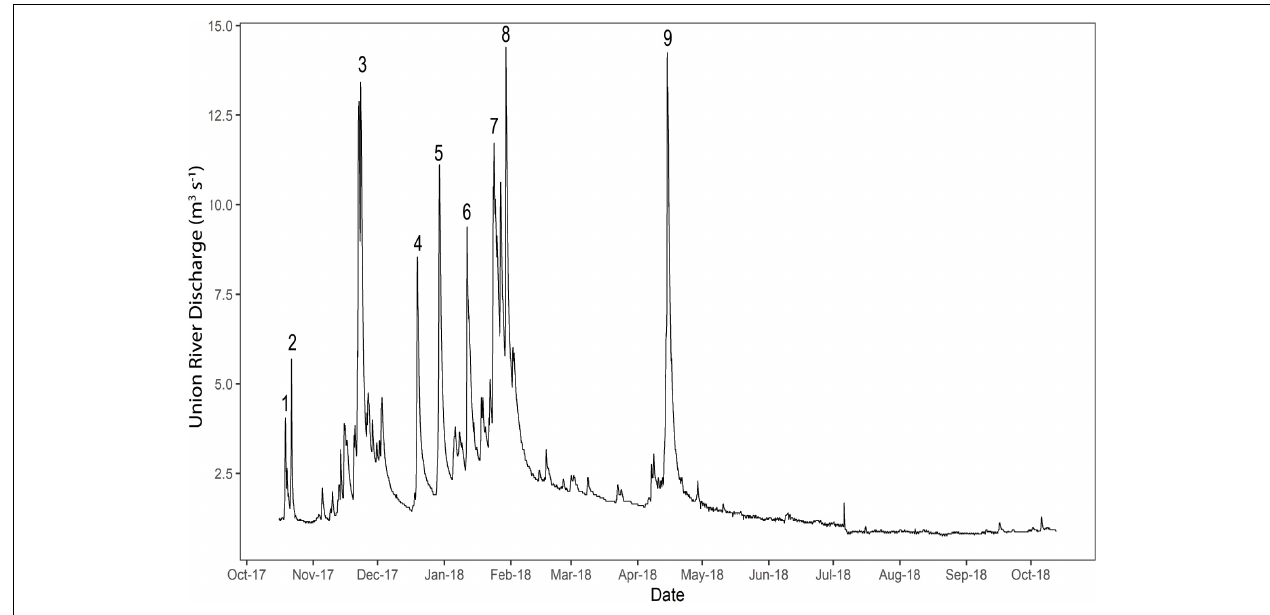
FIGURE 2 | Time series of discharge corrected from Huge Creek discharge data (USGS, 2018) with the storm rainfall (1-9) identified.